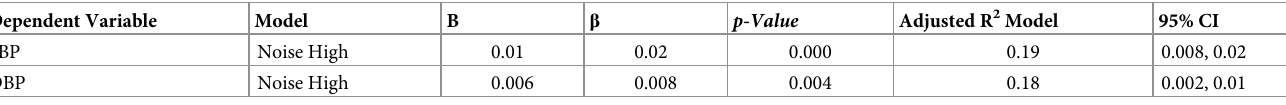
Table 3. Association between blood pressure and occupational noise exposure.